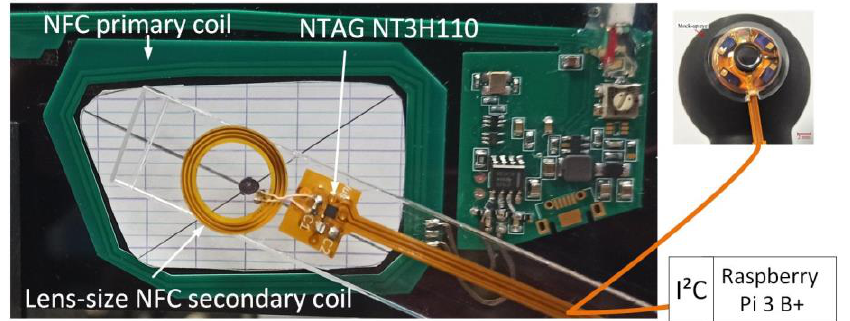
Figure 5. Powering the scleral lens by mean of NFC. The flexible ribbon connects the NFC chip to the encapsulated electronics to ease prototyping and the Raspberry card to retrieve the gaze direction.